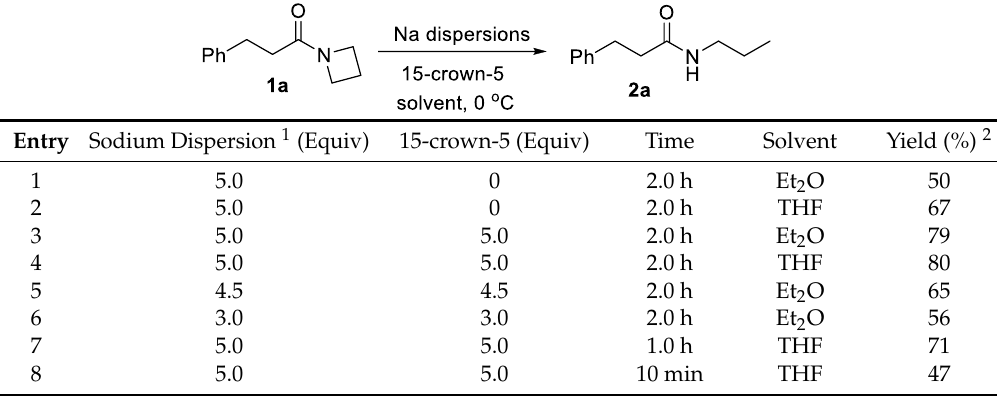
Table 1. Optimization of selective C-N σ bond cleavage in azetidinyl amides by Na/15-crown-5 1 .